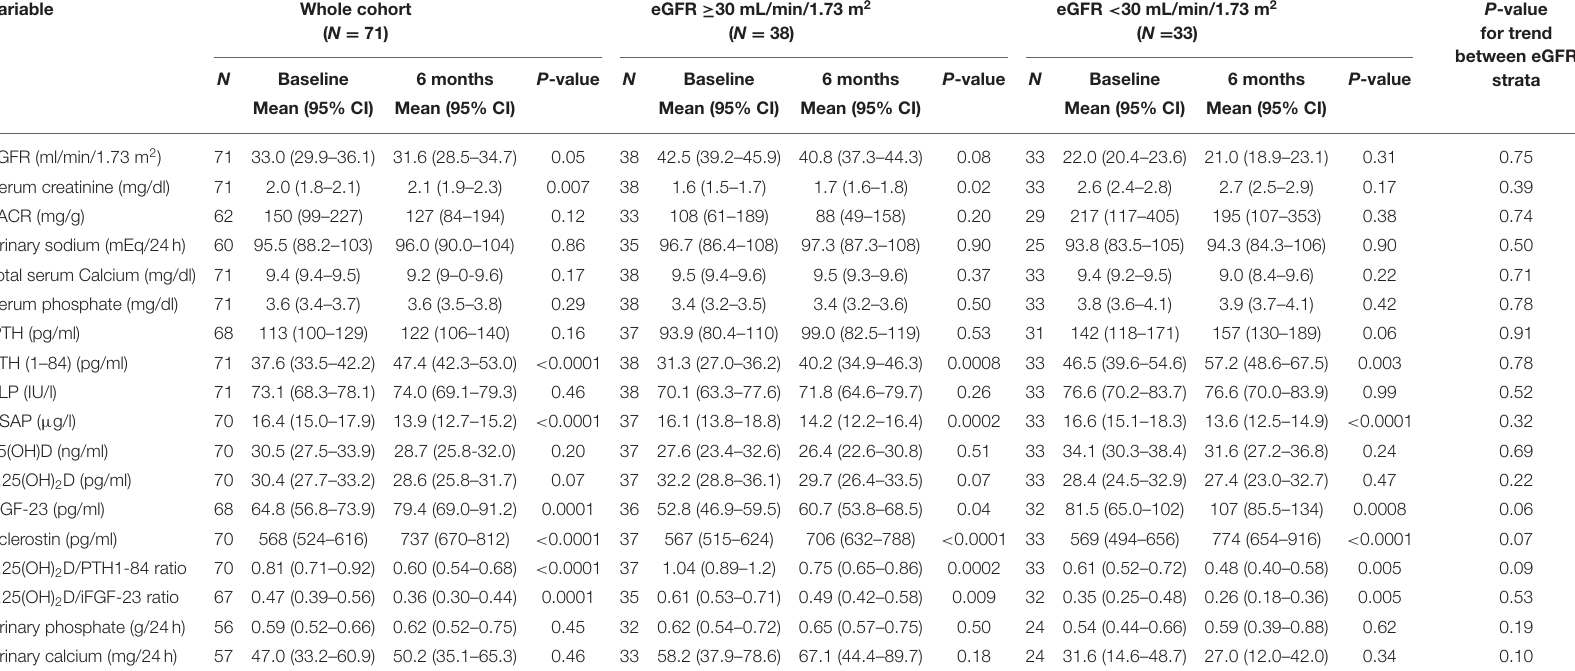
TABLE 5 | Changes in renal and mineral parameters between baseline and 6-months follow up, stratified according to basal eGFR.